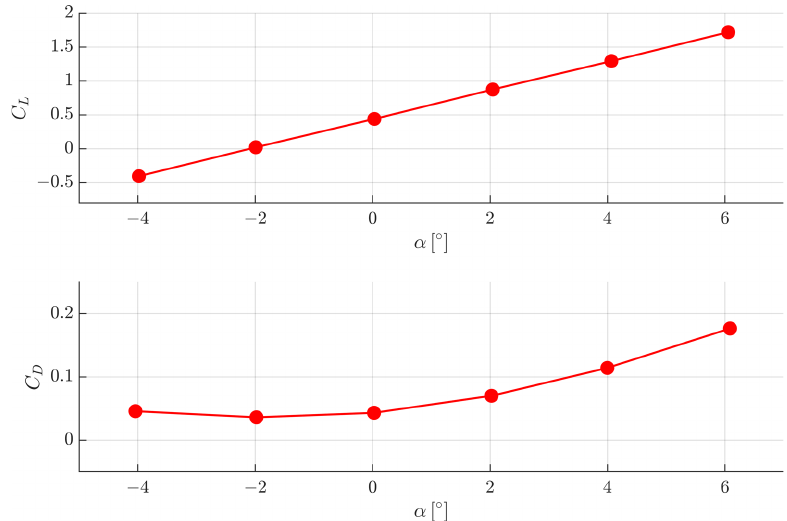
Figure 26. The curves of estimated aerodynamic characteristics. Table 11. Lift-and-drag characteristics at various speeds.